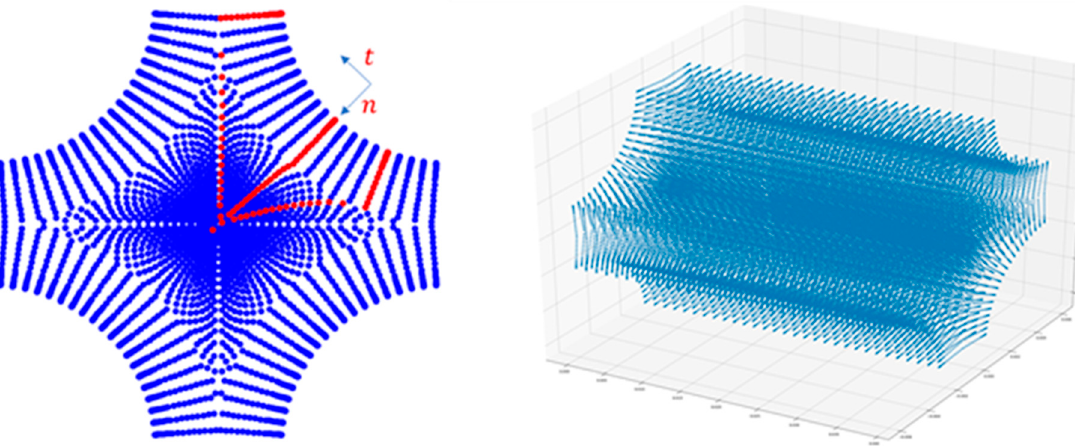
Figure 3. Probe configuration for data collection on a plane. The probes are organized into 20 loci in each quadrant, yielding a homogeneous distribution. All planes, along axial length, shown on right, totaling 84,908 probes.